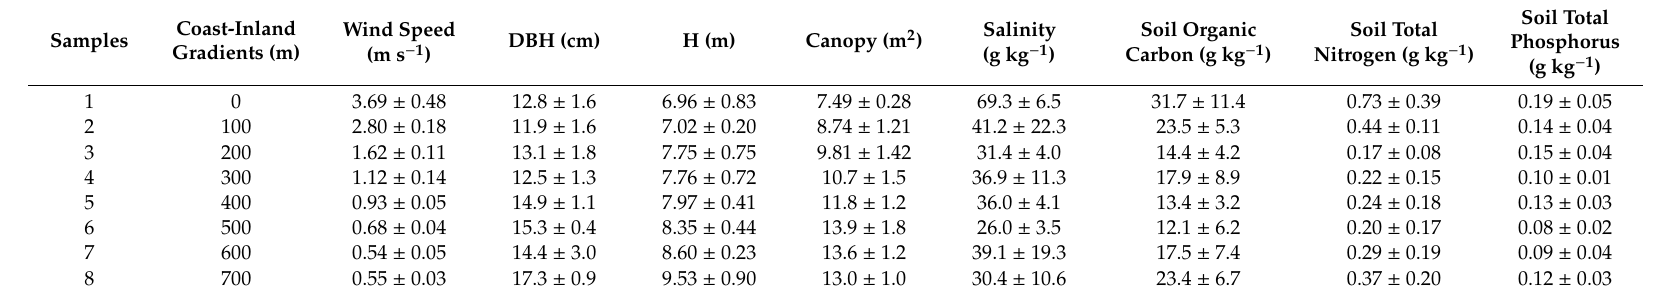
Figure 1. Location of the study site. Table 1. Stand characteristics of Pinus thunbergii